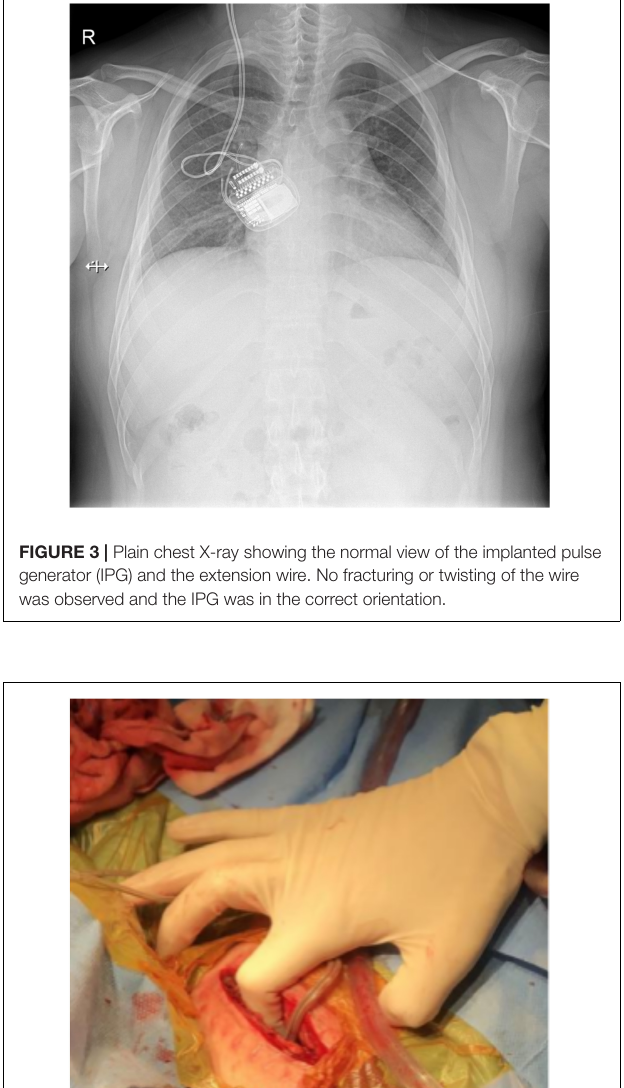
r-IPG. A shallower pocket, 1 cm underneath the skin surface, was created to accommodate the r-IPG. The charging capability of the r-IPG was restored without complications to